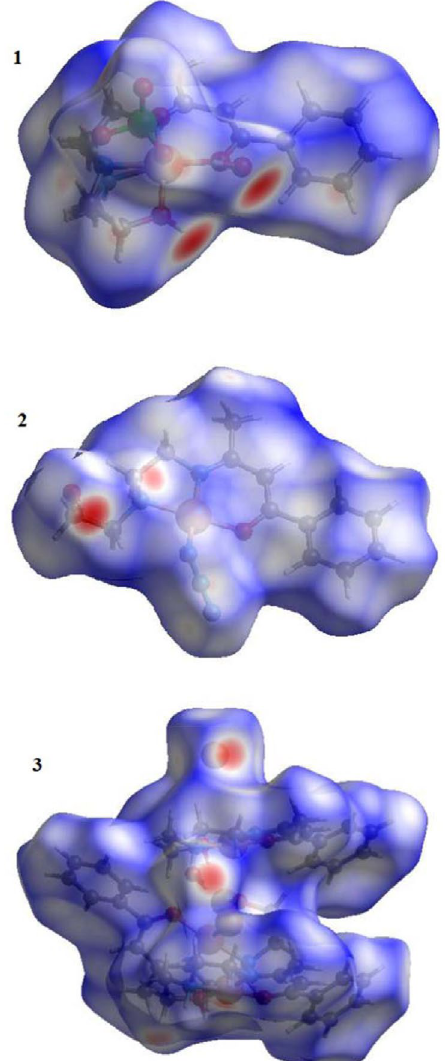
norm for complexes 1–3